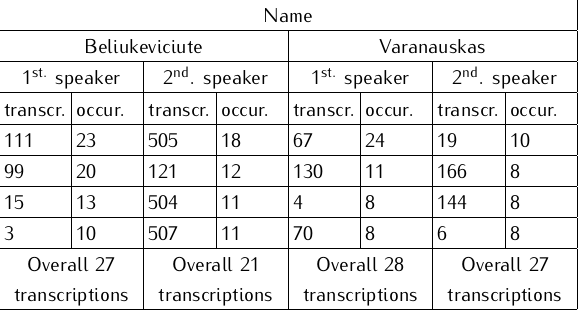
Table 1. The four most frequently recognized transcriptions, for the two speakers and for the two Lithuanian